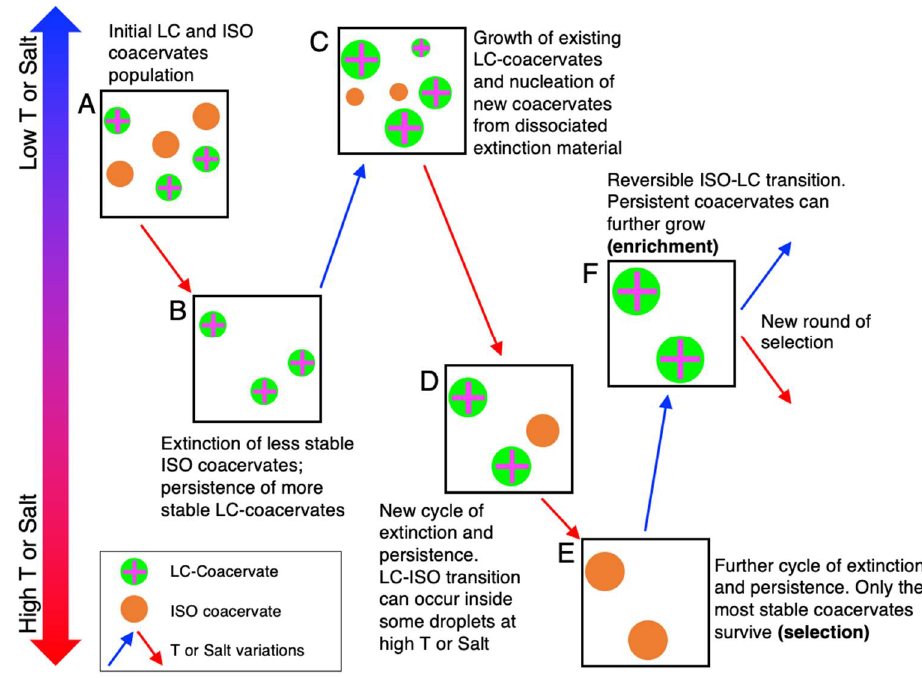
Figure 4. Selective evolution of LC-coacervates through variations in temperature, T, or salinity caused by environmental cycles. A mixed population of coacervates with di ff erent stabilities (due to